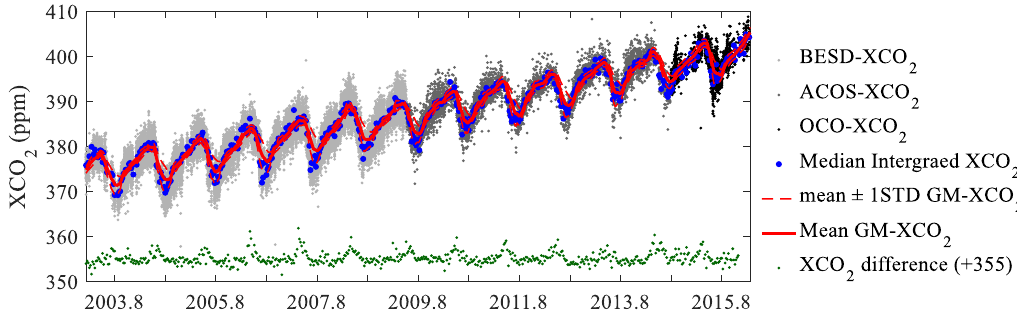
Figure 9. Integrated multi-satellite XCO 2 records and GM-XCO 2 over Eastern China. Light gray, dark gray. and black points represent the integrated BESC-XCO 2 , ACOS-XCO 2 , and OCO-XCO 2 points from 2003 to 2016 in EC. Blue points are the median value of integrated XCO 2 . Red line is the regional mean (solid) GM-XCO 2 ± 1 STD (dashed). Dark green points are the difference between mean GM-XCO 2 and median integrated XCO 2 (+355 ppm).